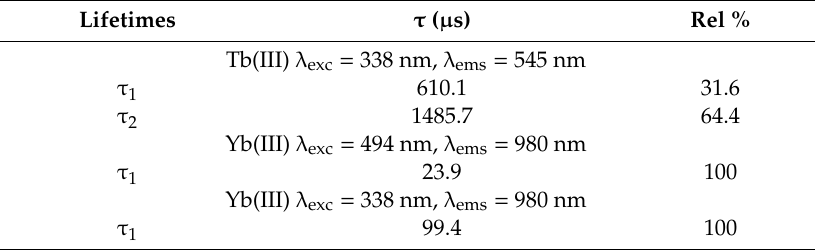
Table 4. Lifetimes of the different Tb(III) and Yb(III) emissions observed